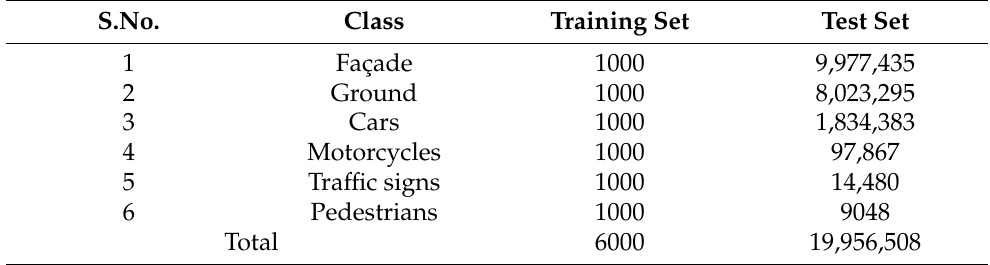
Table 4. For the Paris-rue-Madame database, the number of samples per class.